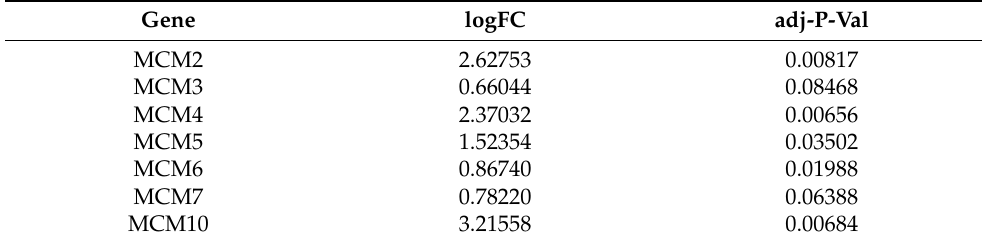
Table 1. MCM expression in aortic dissections vs. normal